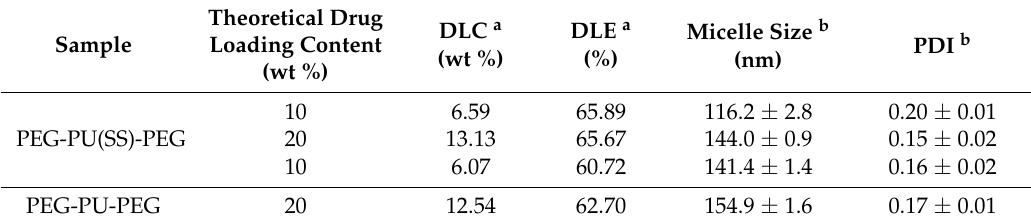
Table 3. Characteristics of DOX-loaded PEG-PU(SS)-PEG micelles and PEG-PU-PEG